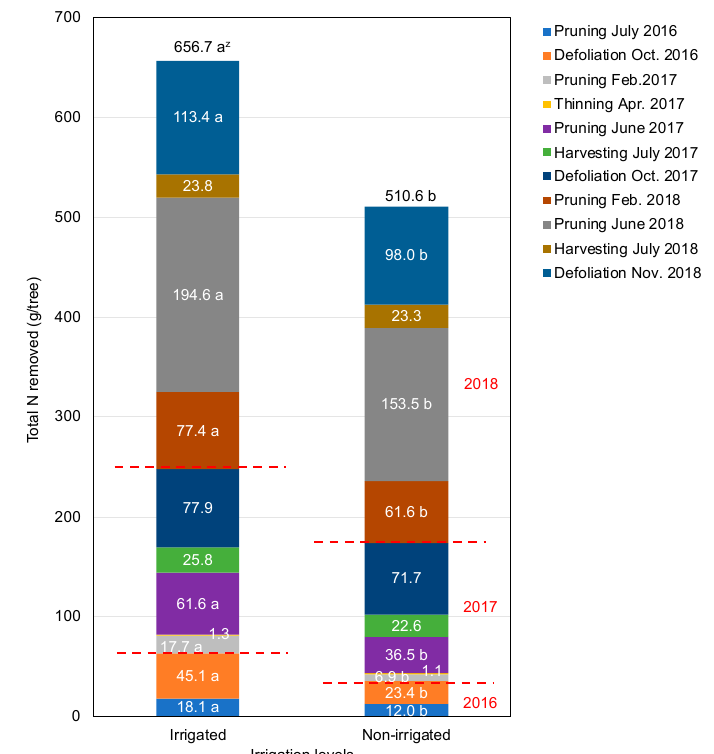
Figure 5. Total N removed per tree for the different irrigation levels (irrigated vs. non-irrigated) of “Julyprince” peaches in 2016, 2017, and 2018. For each removal event (different colors), the means are shown inside the bars. z Means followed by a different letter within a removal event are significantly different by Tukey’s honestly significant different test, P ≤ 0.05. Means without letters indicate non-statistical differences, P > 0.05.